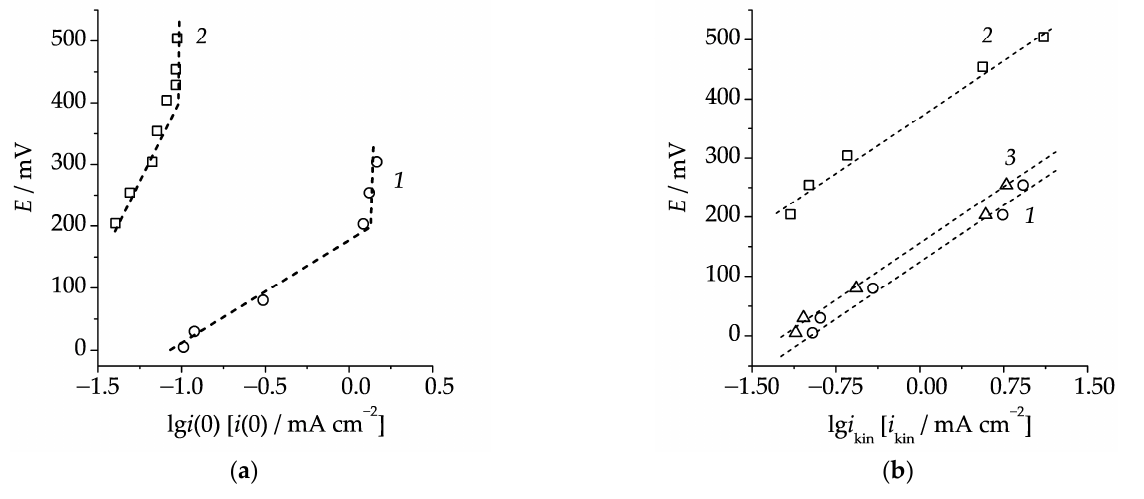
Figure 6. Tafel plots obtained in 1 М HCOOH + 0.05 M H 2 SO 4 for (1)—Cu 85 Pd 15 alloy after modification at q mod = 24 mC·cm − 2 and E mod = 630 mV; (2)—palladium; (3)—Cu 85 Pd 15 alloy after modification at q mod = 24 mC·cm − 2 and E mod = 630 mV with correction for the degree of surface development. ( a ) without adjustment, and ( b ) with adjustment for the limiting current density of electro-oxidation.